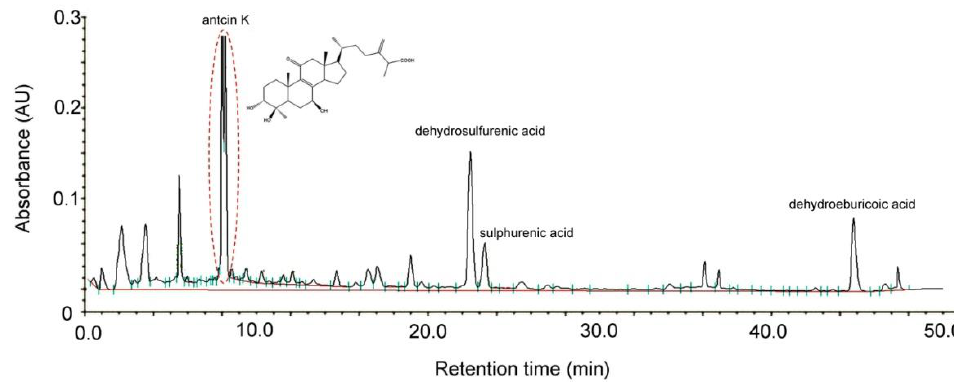
Figure 1. Chromatographic fingerprint analysis by HPLC of Antrodia camphorata . The bioactive substances present in HPLC chromatographic fingerprint were antcin K, dehydrosulfurenic acid, sulphurenic acid, versisponic acid D, and dehydroeburicoic acid. Antcin K (3 α ,4 β ,7 β -tri-hydroxy4 α -methylergosta-8,24(28)-dien-11-on-26-oic acid, 2) is an active triterpenoid from the fruiting body of Antrodia camphorata that was provided from ARJIL Pharmaceuticals LLC. We adopted antcin K standard products to prepare a standard solution, and analyzed and compared the standard and sample solution with the same analytical method. AU, arbitrary perfusion units; HPLC, high-performance liquid chromatography.